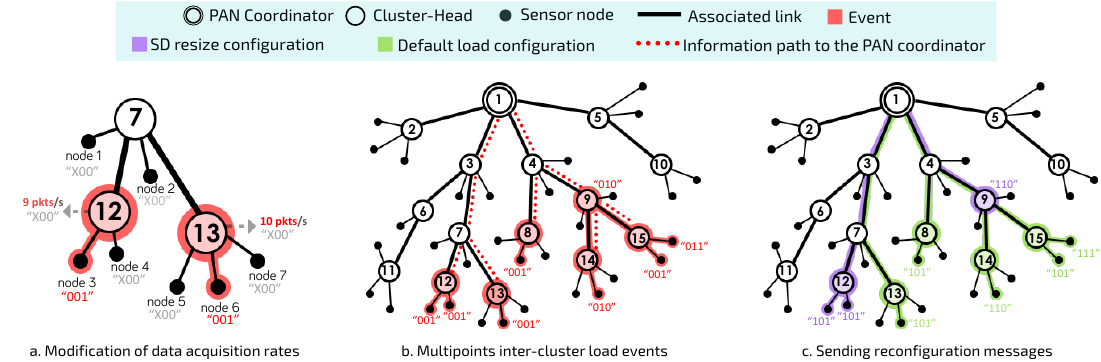
Figure 6. Network behaviour considering the details of critical event detection and